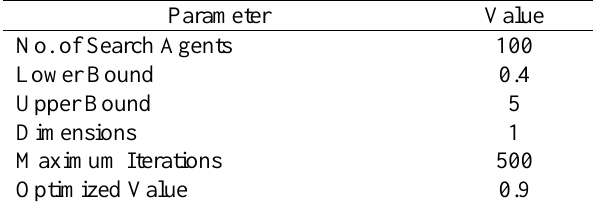
Table 2: Parameters value taken for Dragonfly optimization